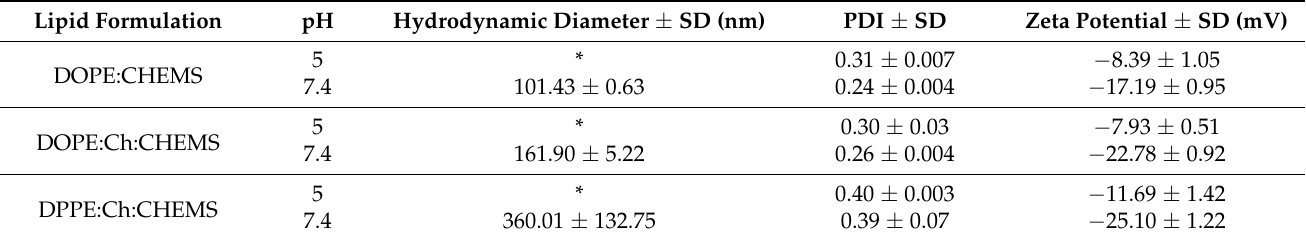
Table 4. Hydrodynamic diameter (nm), polydispersity index (PDI) and zeta potential (mV) and respec- tive standard deviation (SD) in acidic (pH = 5) and physiological (pH = 7.4) conditions of the